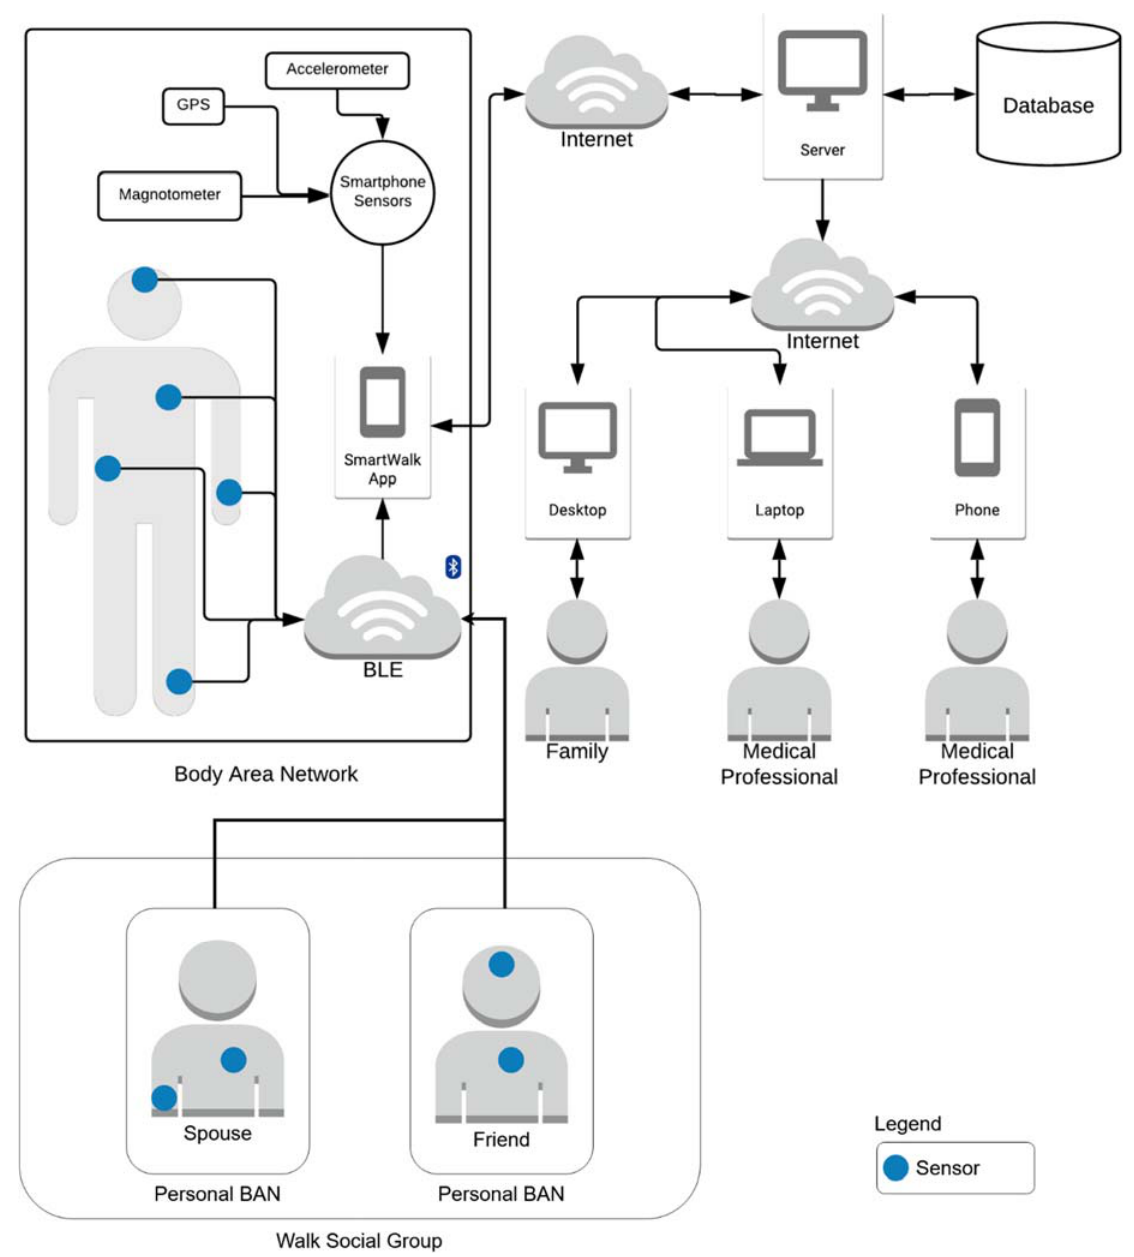
Figure 1. Architecture of the SmartWalk system.